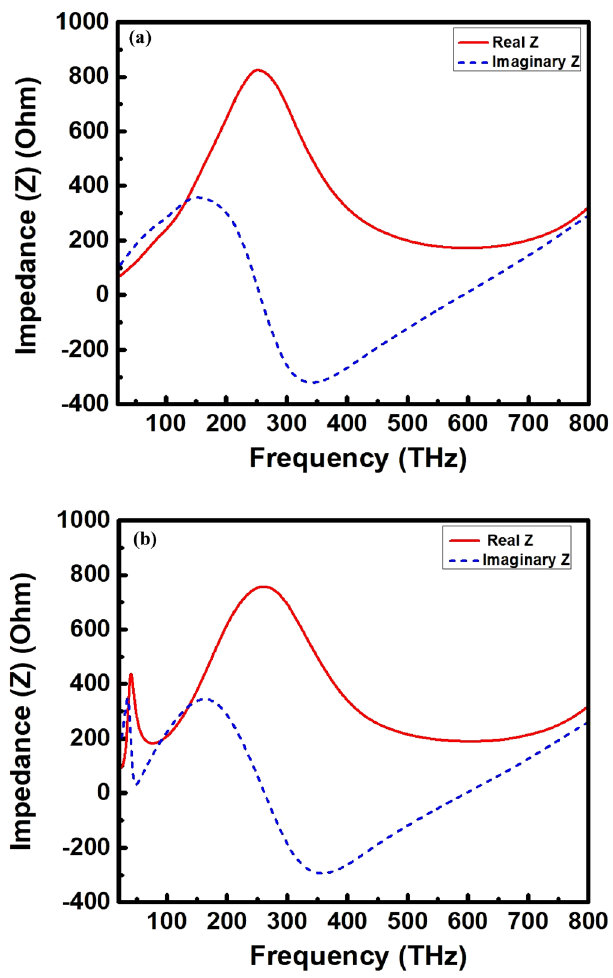
Figure 4. The real and imaginary parts of the impedance for ( a ) unit cell structure and ( b ) 3 × 3 array